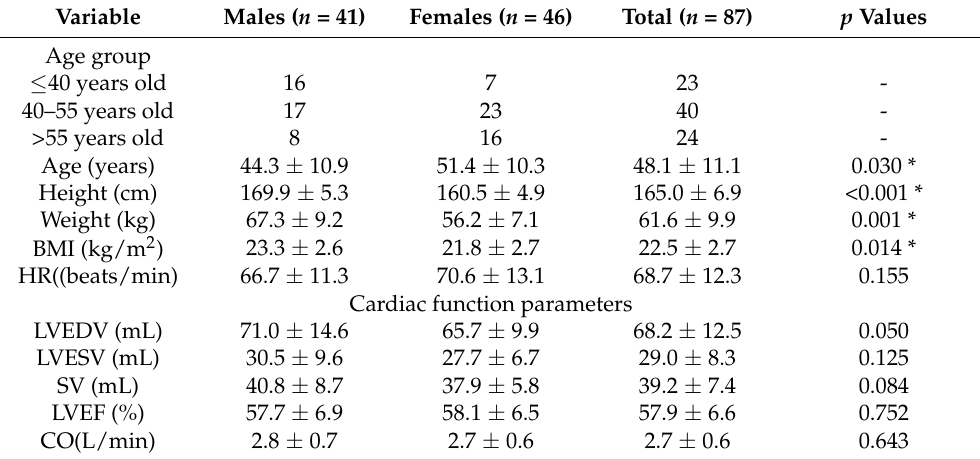
Figure 2. Flowchart of patients who met the inclusion/exclusion criteria for the study. Table 1. Clinical indicators and cardiac function parameters of the study